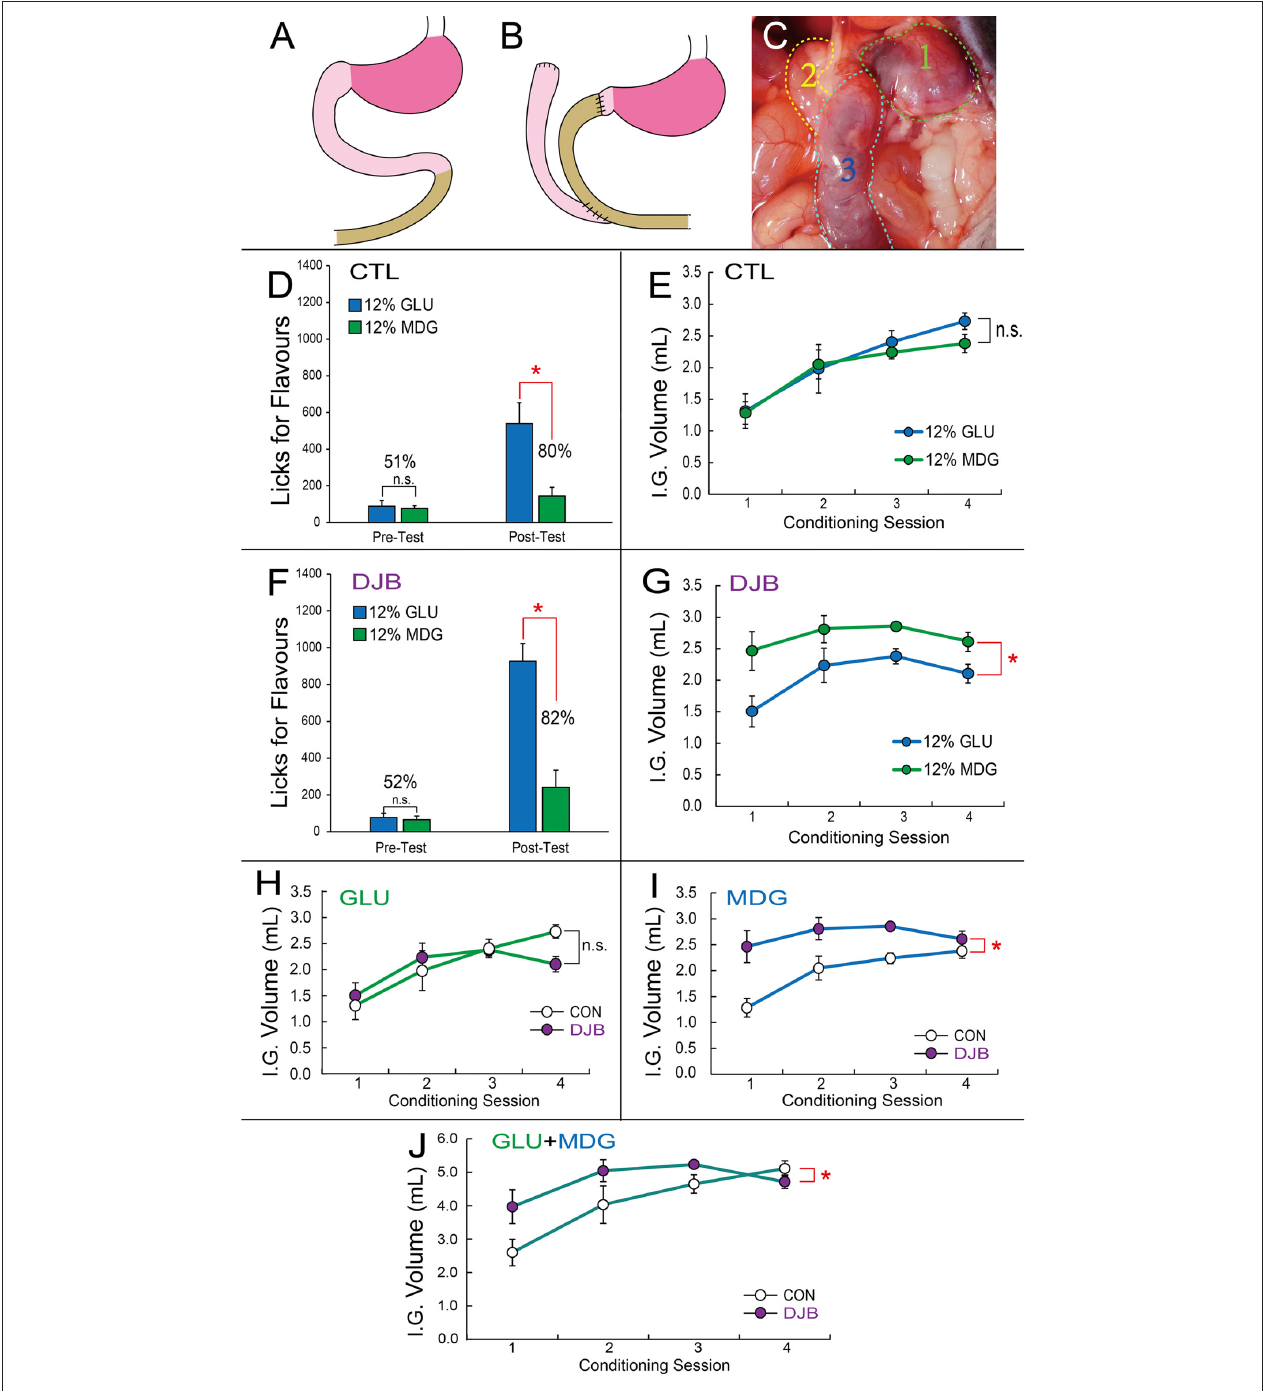
FIGURE 3 | Duodenum jejunum bypass (DJB) mice displayed greater preferences for flavors associated with metabolizable glucose, despite showing decreased satiety for non-metabolizable glucose. (A,B) Schematic representation of the DJB intervention, which includes duodenal segmentectomy, jejunal-pylorus end-to-end anastomose and duodenal-jejunal end-to-side anastomose. (C) A blue dye was infused through a gastric catheter for assessment of surgical efficacy. In DJB mice the dye was visible only in stomach and jejunum. Legend: (1) Stomach; (2) Duodenum; (3) Distal jejunum. (D) In the sham control group, short-term two-bottle preference tests performed before conditioning sessions (left bars) reveal no differences between number of licks produced for the 12% GLU-associated vs. 12% MDG-associated flavor ( post hoc paired t -test, N = 5, p = 0.8), resulting in preferences of 51% for the 12% GLU-associated flavor. However, after conditioning sessions (right bars), a significant increase in the number of licks for the 12% GLU-associated flavor ( ∗ p = 0.016) was observed, resulting in a preference of 80% for